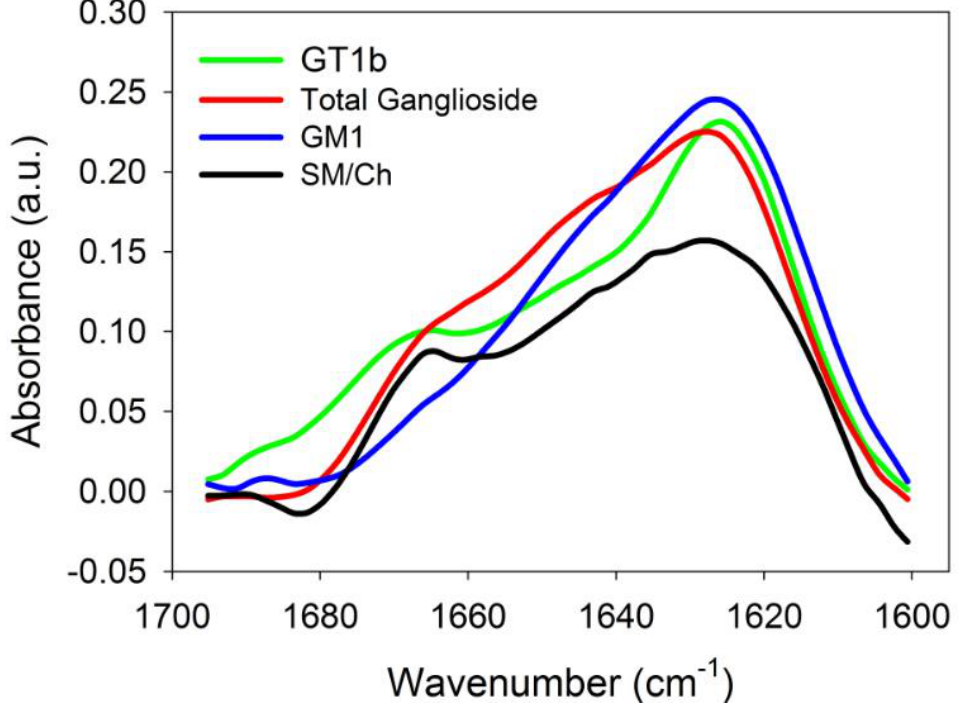
Figure 2. The 1600–1700 cm −1 region of the IR spectrum of Aβ42 in mixtures with vesicles of various lipid compositions. lipid